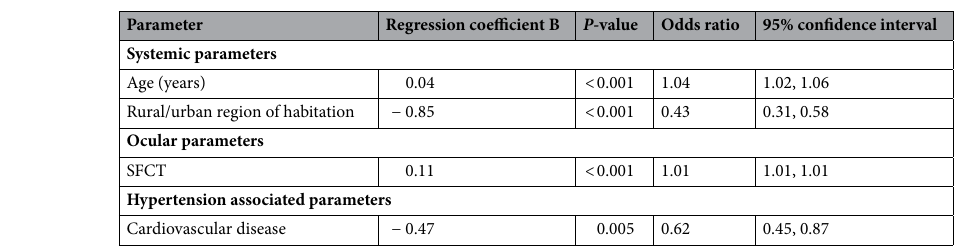
Table 3. Associations between the presence of hypertensive retinopathy and systemic and ocular parameters in the Beijing Eye Study